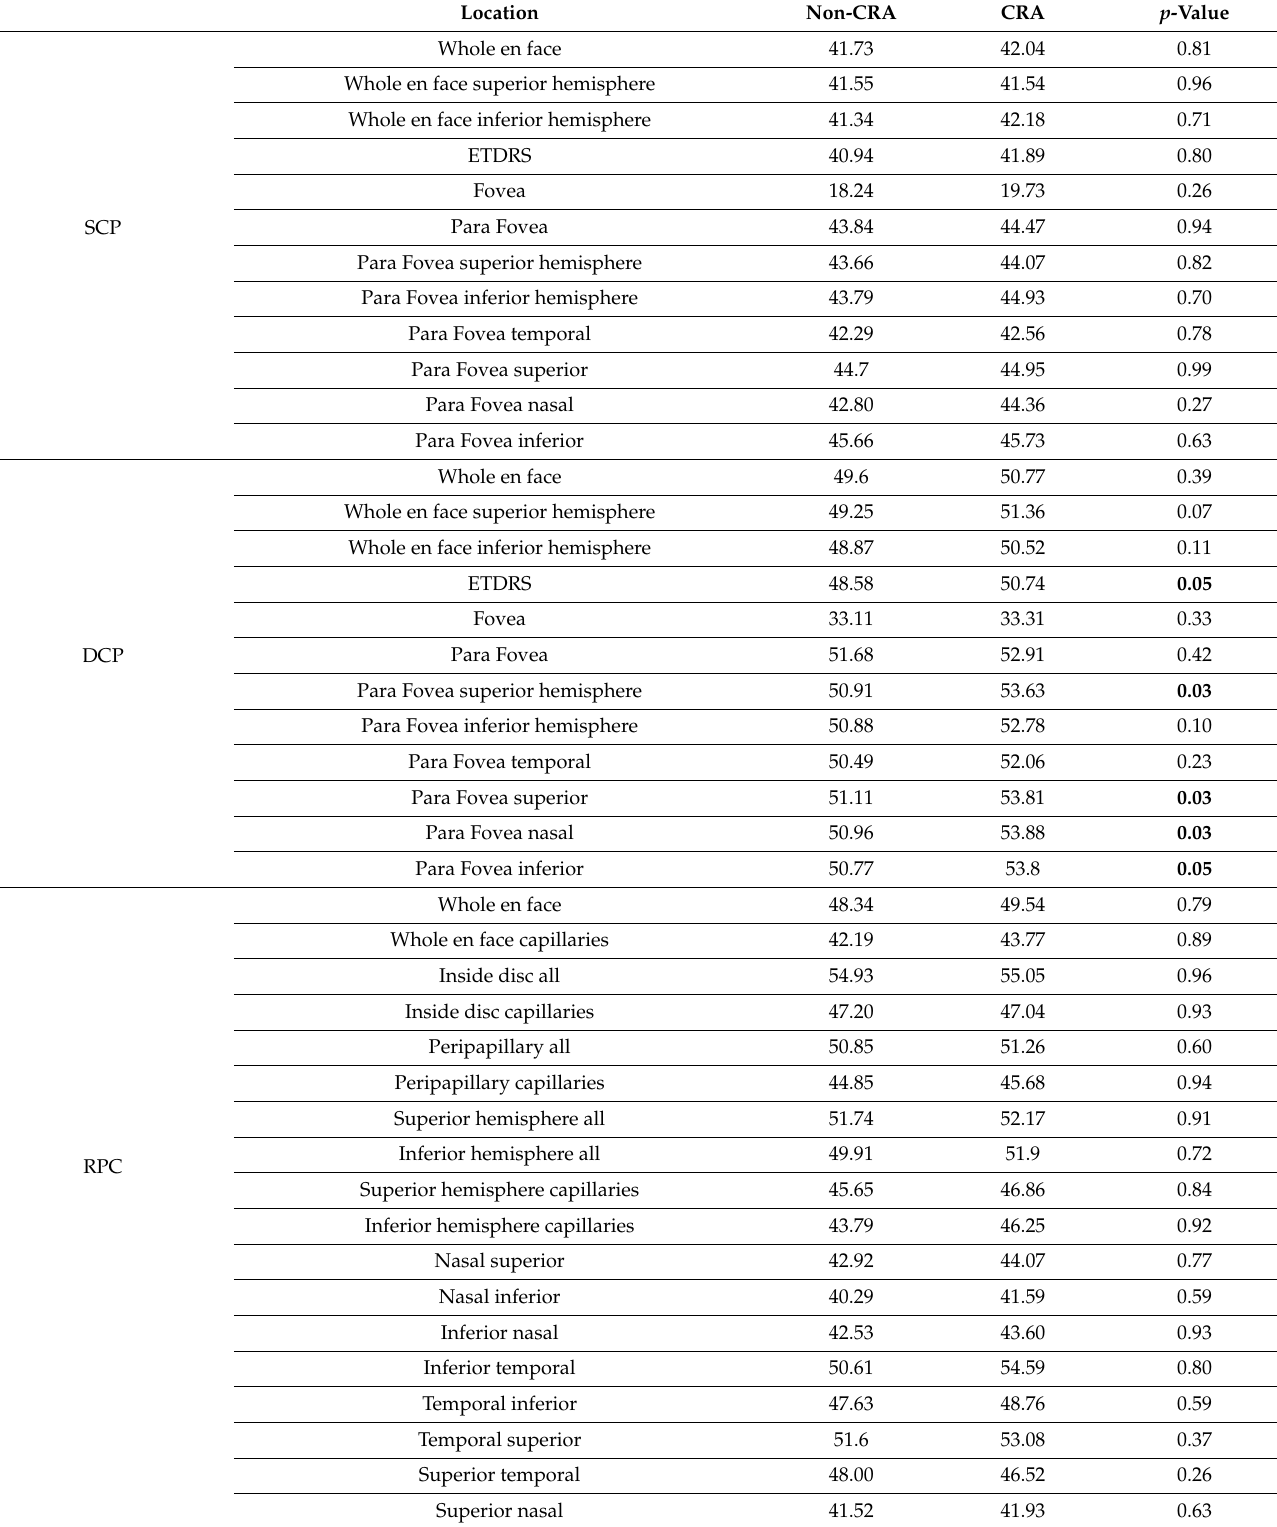
Table 3. FD in the CRA and non-CRA groups measured by